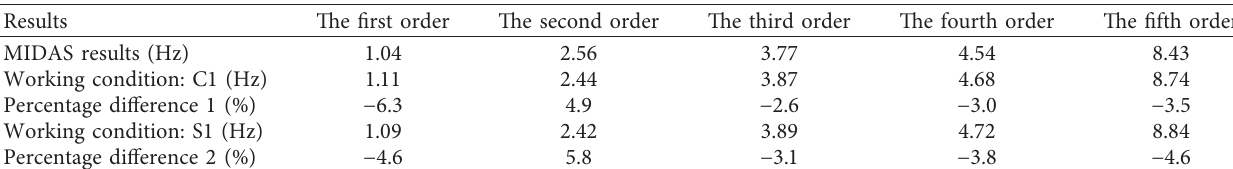
Figure 12: Effective stability diagram. (a) Effective stability diagram (working condition: C1). (b) Effective stability diagram (working condition: S1). Table 3: Comparative analysis results of